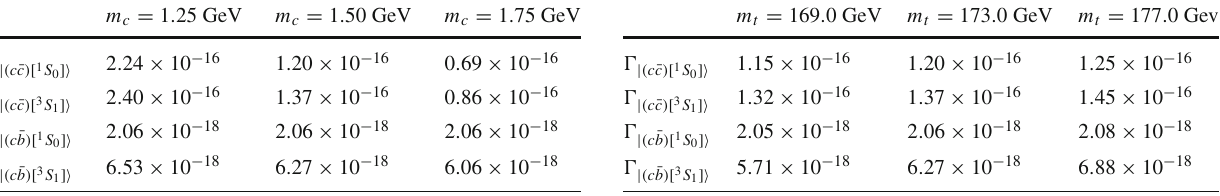
Table 2 Uncertainties of the decay width for the process t → | ( c ¯ Q ) [ n ](cid:5) + Q + Z 0 by varying m ∈ [ 1 . 25 , 1 . 75 ] GeV c m c = 1 . 25 GeV m c = 1 . 50 GeV m c = 1 . 75 GeV